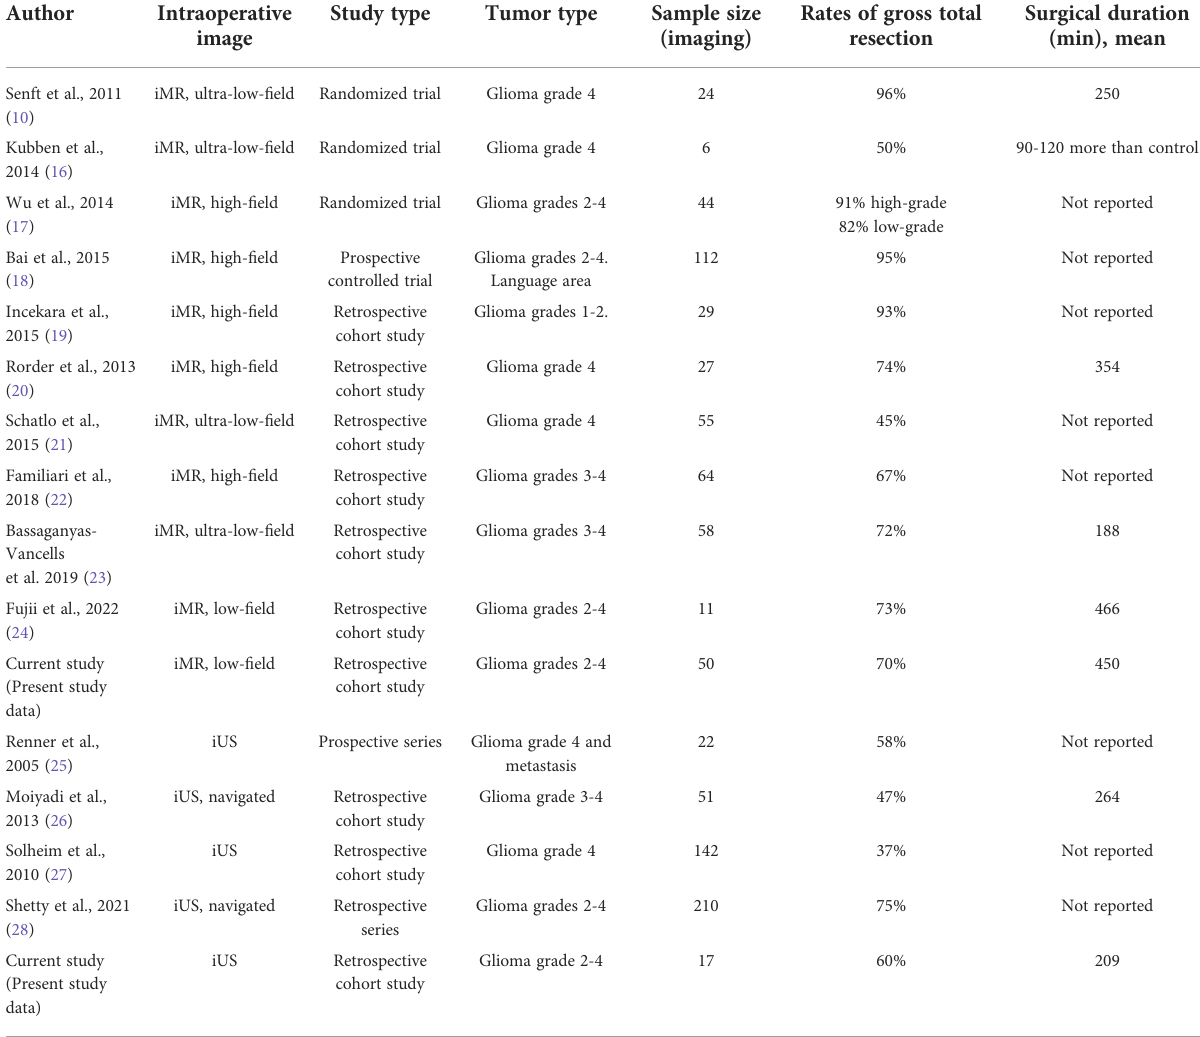
TABLE 5 Summary of the main trials and observational studies evaluating intraoperative ultrasound and magnetic resonance imaging for the resection of high and/or low-grade gliomas.